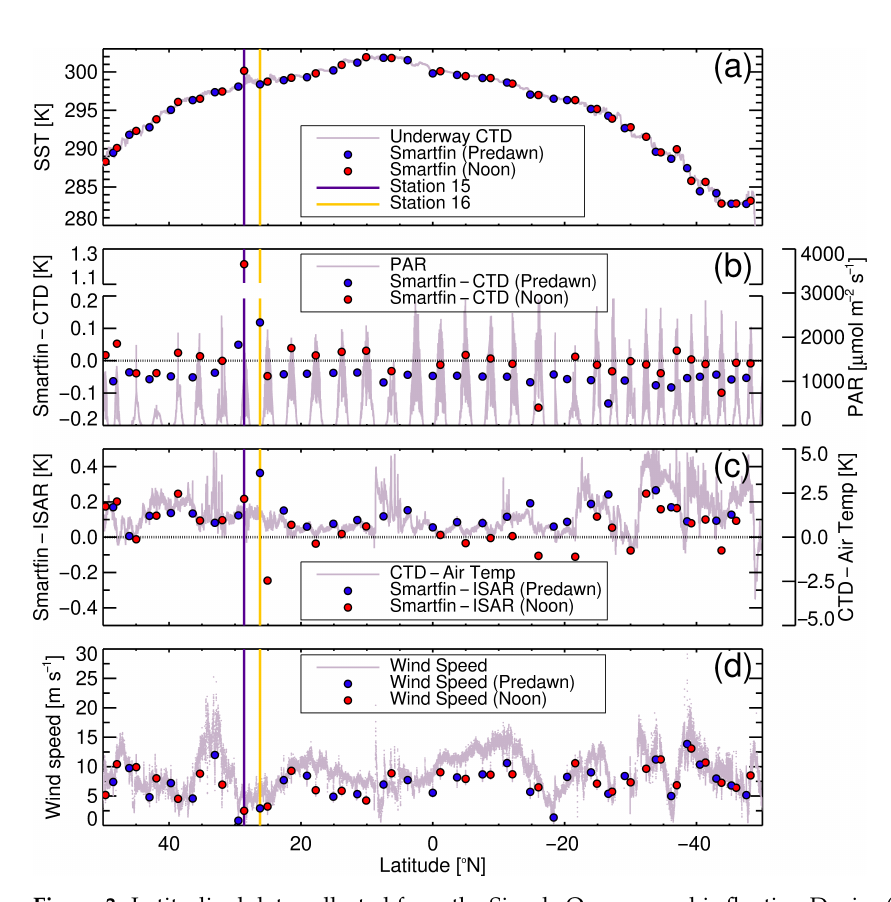
Figure 3. Latitudinal data collected from the Simple Oceanographic floating Device (SOD), ISAR and underway systems on the Atlantic Meridional Transect cruise 28. ( a ) Latitudinal transect of SST from the underway CTD and Smartfin. ( b ) Differences in SST between the Smartfin and underway CTD at stations along the latitudinal transect, with underway Photosynthetically Available Radiation (PAR) plotted in the background. ( c ) Differences in SST between the Smartfin and ISAR at the stations along the latitudinal transect, with the sea-air temperature gradient (computed independently from the underway CTD and air temperature sensors) in the background. ( d ) Wind speed at each of the 62 stations, with the along-track wind speed plotted in the background. Station 15 and 16, used in subsequent analysis (see Figure 5), are shown by the dark purple and yellow vertical lines. Dotted lines in ( b , c ) represent